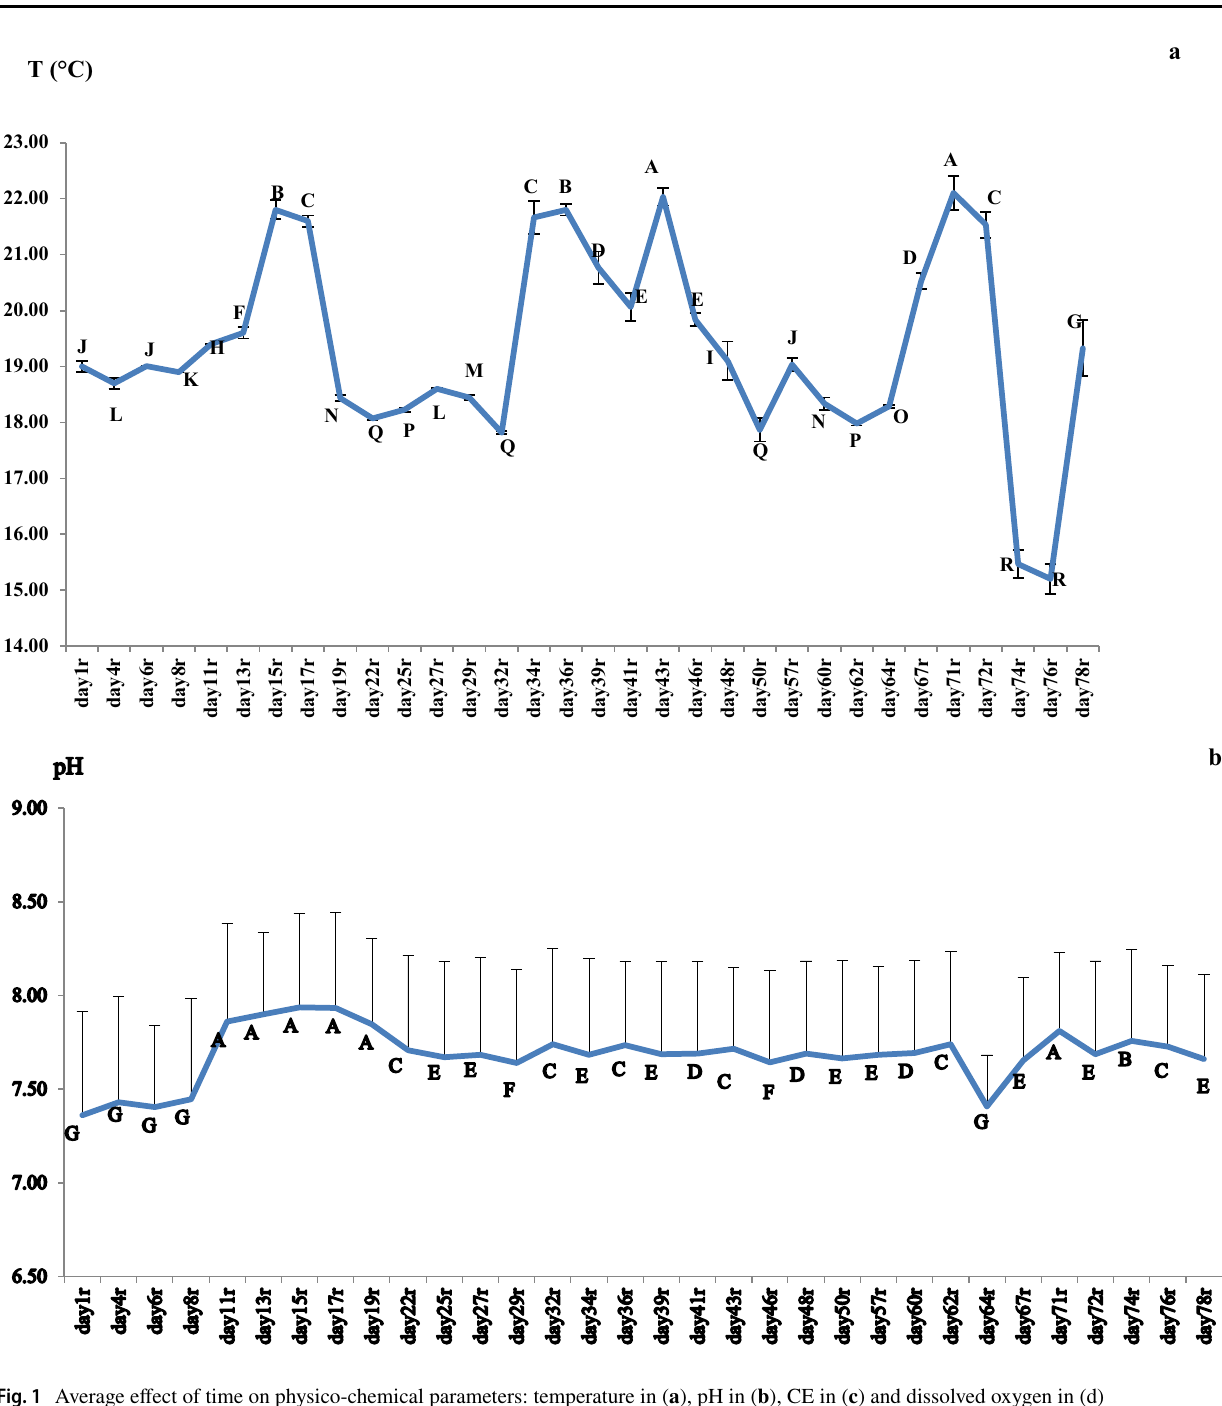
Fig. 1 Average effect of time on physico-chemical parameters: temperature in ( a ), pH in ( b ), CE in ( c ) and dissolved oxygen in